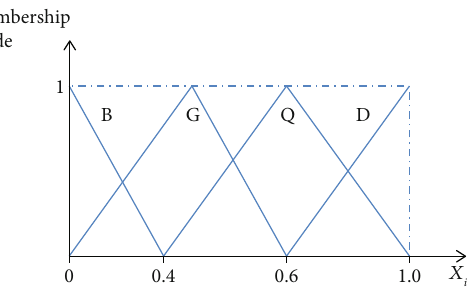
Figure 2: Membership functions for linguistic rating